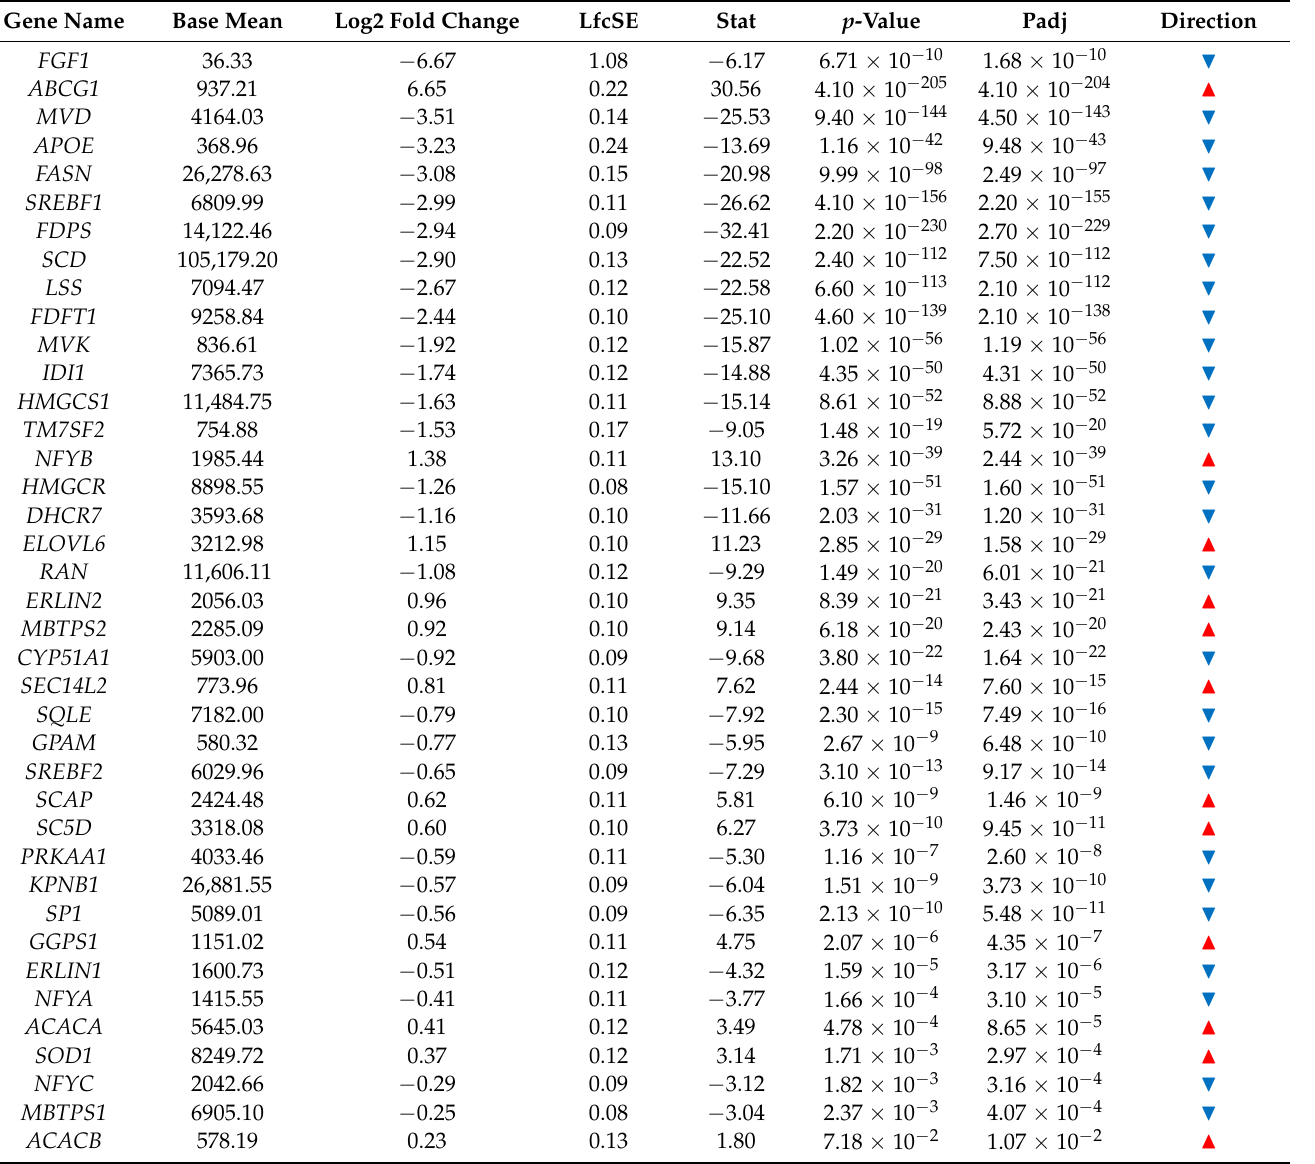
Arrows indicate up-(red) or downregulated (blue) genes in H1563 compared to H1299